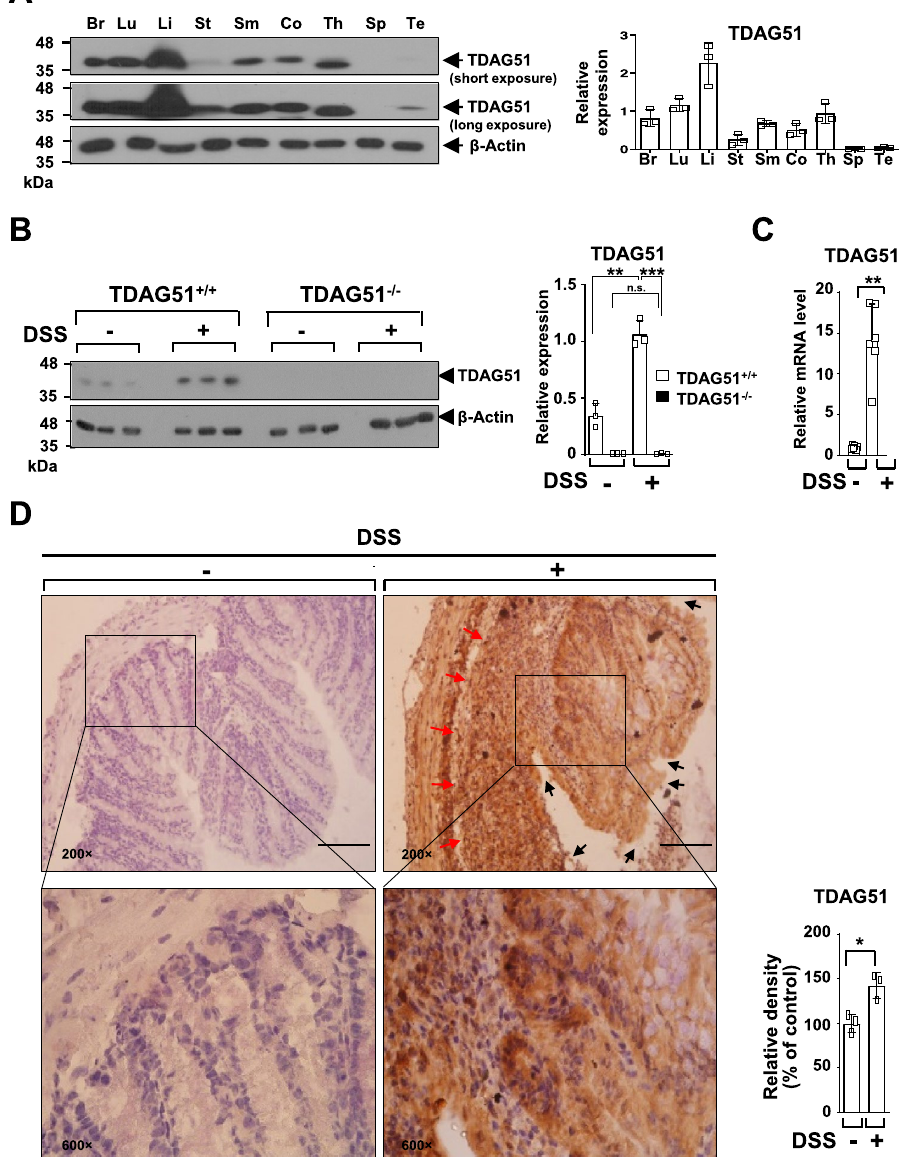
Figure 1. TDAG51 expression is elevated in the colon tissues of DSS-induced experimental colitis model mice. ( A ) TDAG51 expression in various mouse tissues. Organs and tissues were collected from 8-week-old C57BL/6J male mice. β-Actin was used as a loading control. The relative levels of TDAG51 from immunoblotting with an anti-TDAG51 antibody (left panel) were quantified by densitometry and normalized to β-actin (right panel). Br brain, Lu lung, Li liver, St stomach, Sm small intestine, Co colon, Th thymus, Sp spleen, Te testis. ( B ) Elevated TDAG51 expression in the colon tissues of DSS-induced experimental colitis model mice. C57BL/6J male mice (8 weeks old, n = 12 per group) were administered 1.7% DSS in drinking water for 4 days followed by water for 3 days in 3 cycles. Three randomly selected mice in each group were sacrificed on day 21. The protein levels of TDAG51 in the distal anorectal region of colon tissues were analyzed by immunoblotting (left panel) and quantification (right panel). ( C ) The relative mRNA levels of TDAG51. The distal anorectal region of colon tissues of DSS-induced colitis mice was subjected to real-time PCR analysis. The data were normalized to β-actin levels. ( D ) TDAG51 expression levels in the colon tissues of DSS-induced colitis model mice. The distal anorectal region of colon tissues of DSS-induced colitis mice was sectioned and analyzed by immunohistochemistry with an anti-TDAG51 antibody and hematoxylin (left panel; original magnification, ×200 and ×600). The black arrow marks destruction of structural integrity; the red arrow indicates infiltration of immune cells. The relative expression of TDAG51 was analyzed (right panel) by comparison of immunopositive cells (brown) with relevant counterstained cells (purple nuclei). Scale bars, 100 μm. * P < 0.05. ** P < 0.01. *** P <